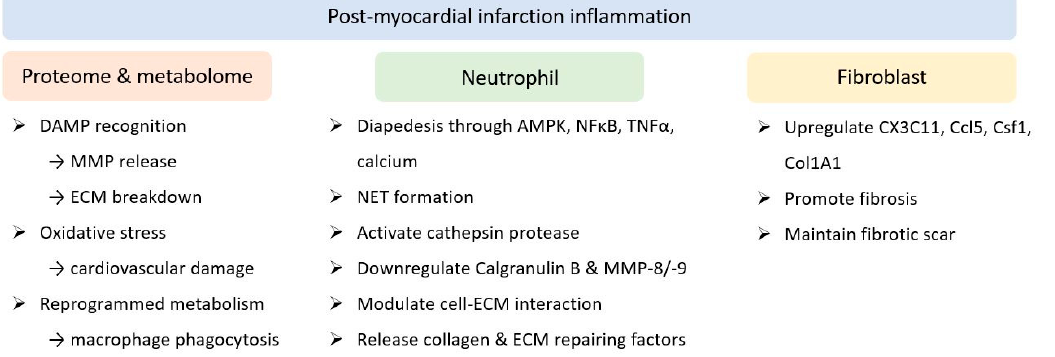
Figure 1. Molecular alterations secondary to inflammation after myocardial infarction . Landscape of proteome and metabolome, as well as neutrophil and fibroblast responses to the inflammatory status. AMPK: AMP-activated protein kinase; DAMP: damage-associated molecular pattern; ECM: extracellular matrix; MMP: matrix metalloproteinase; NET: neutrophil extracellular traps; NF κ B: nuclear factor κ -light-chain-enhancer of activated B cells; TNF α : tumour necrosis factor α